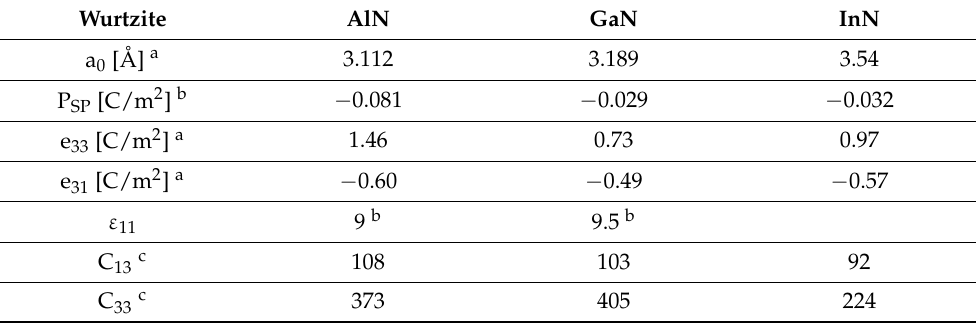
Table 1. Spontaneous polarization, piezoelectric, dielectric constants, and elastic constants of AlN, GaN, and